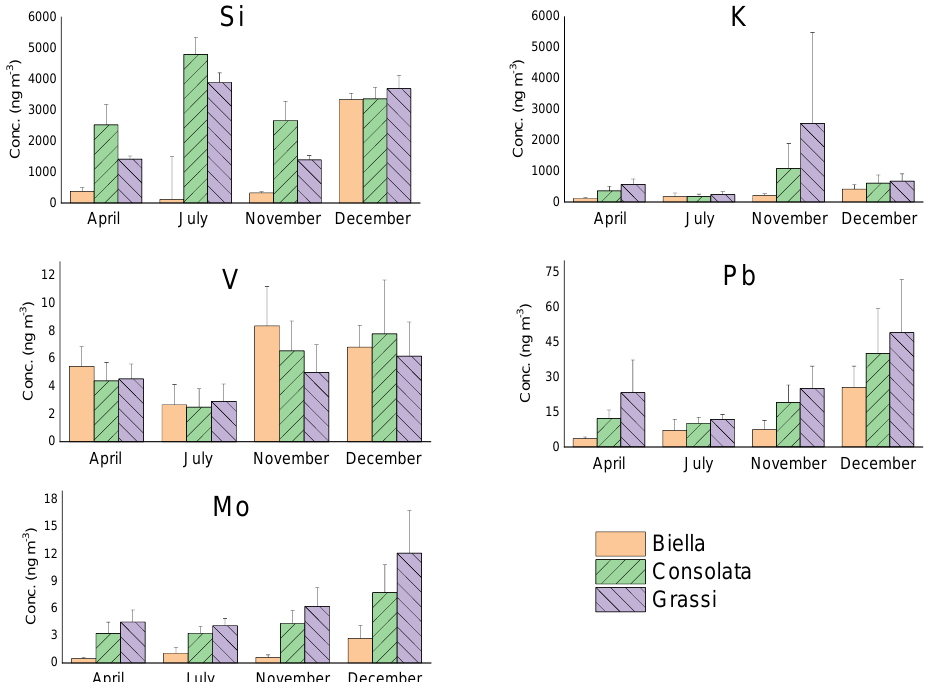
Figure 3. Concentrations of the elements Si, K, V, Pb, and Mo in ng m − 3 for Biella, Consolata, and Grassi sites according to the sampling month. The bars correspond to the positive standard deviation of the data.